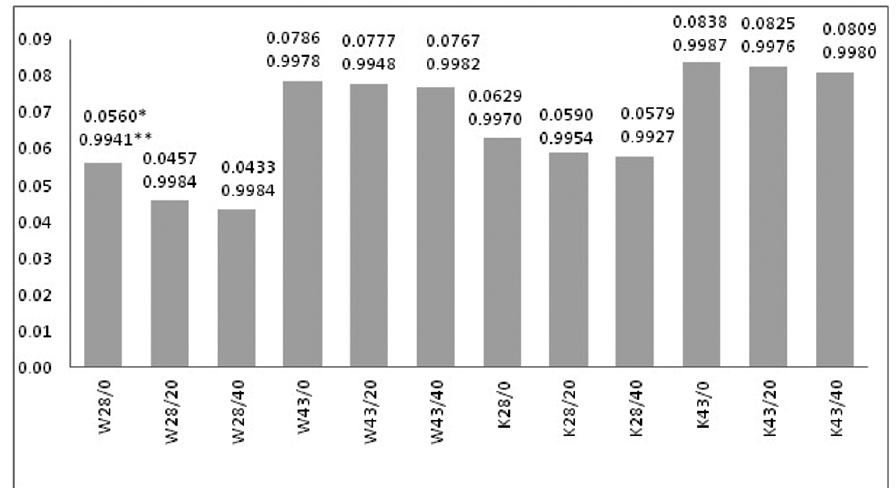
Figure 6. Values of the slope coefficient of the straight line determined from the linear relationship for the heating process (*slope coefficient of the straight line, ** linear coefficient of correlation). The temperature of materials modified with pastes with 20% rather than 40% of MPCM28 and MPCM43 increased faster. Higher MPCM content results in higher heat accumulation, but